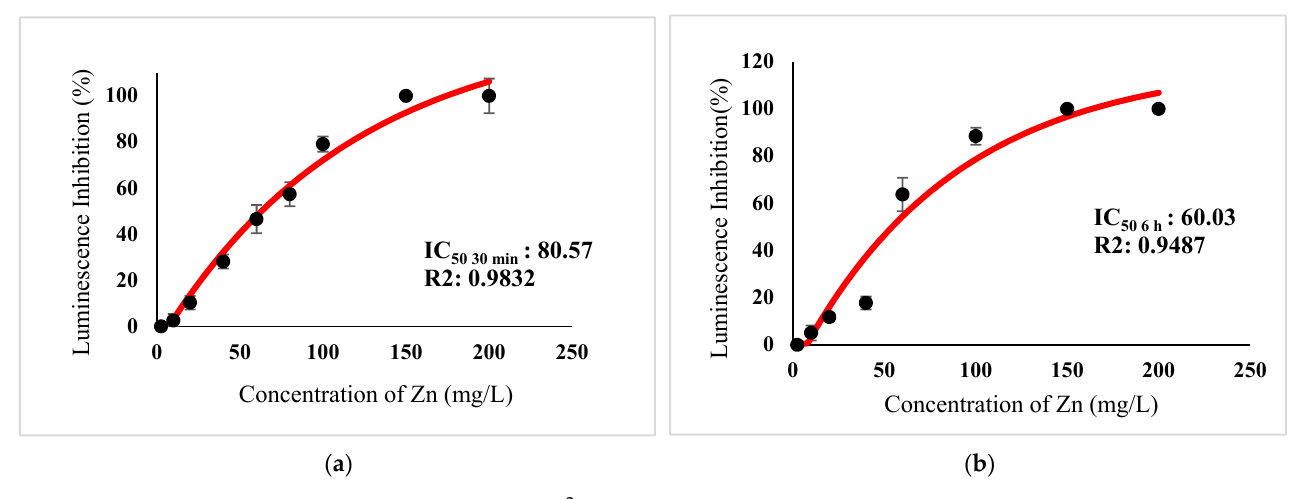
Figure 7. ( a ) Acute and ( b ) Chronic toxicity of Zn 2+ on luminescence inhibition of Photobacterium sp.NAA-MIE. Data represent mean ± SD, n = 3.